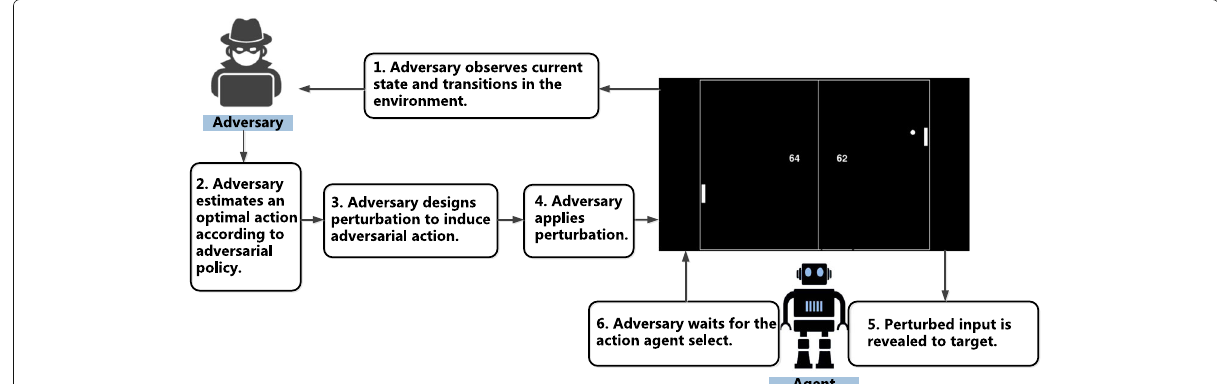
Fig. 6 The exploitation cycle of policyinductionattack (Behzadan and Munir 2017). For the first phase, adversary will observes the current state, and transitions in the environment. Then adversary will estimate the optimal action to select based on the adversrial policy. For the next phase, adversary take perturbation into application, and perturb the target’s input. Finally, adversary will waits for the action that agent